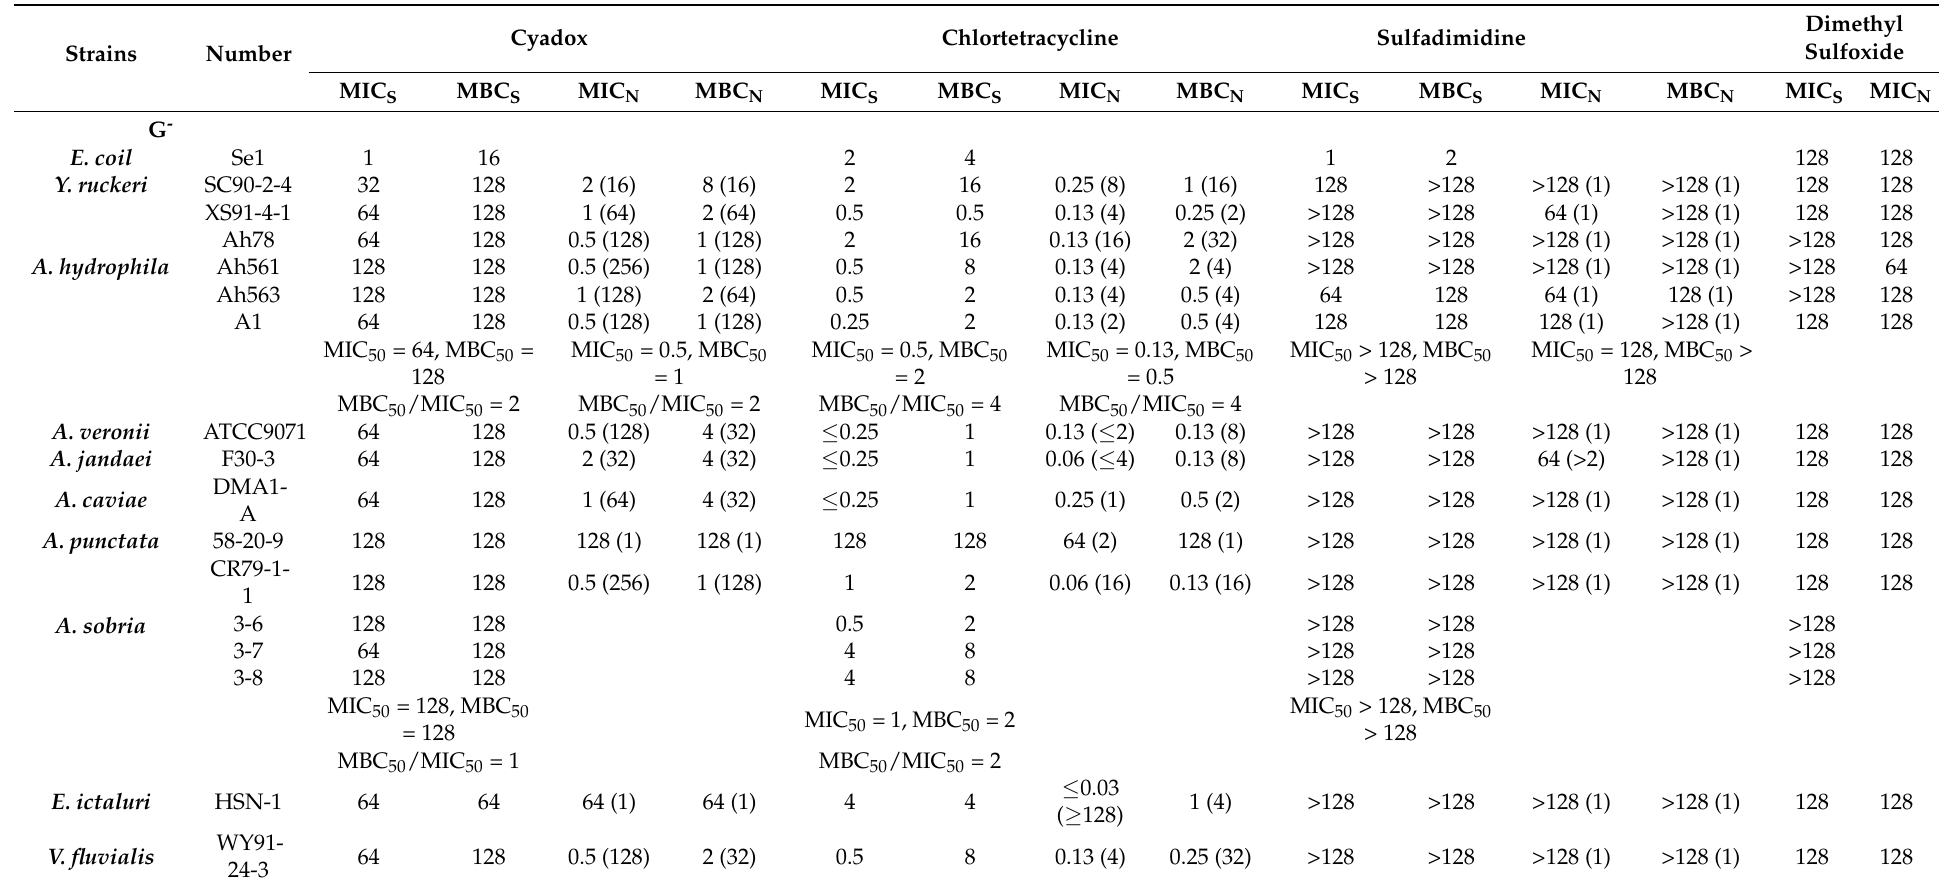
Table 3. Antimicrobial susceptibility of cyadox and controls against common pathogens isolated from fishes (unit: µ